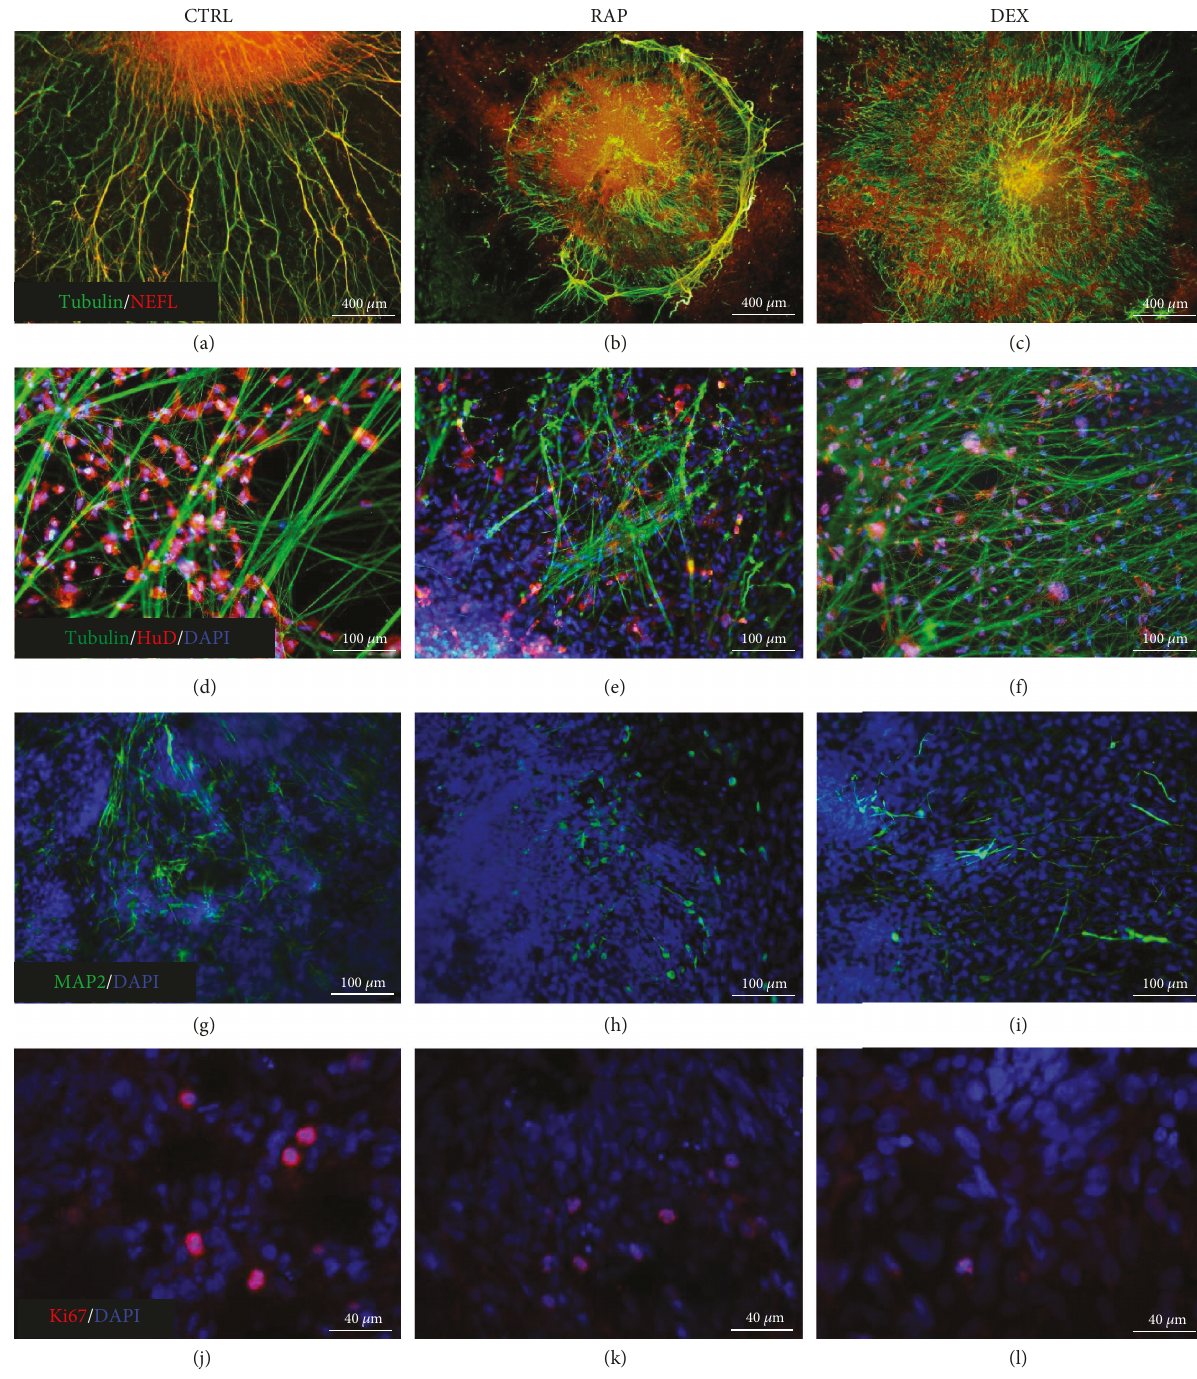
Figure 3: Immuno fl uorescence microscopy to examine the morphologies of cells from retinal organoids after exposure to immunosuppressants (a) Axons in the control group were long and strong and most expressed tubulin and NEFL (detected via immuno fl uorescence staining) indicating that the cells in this group could develop mature axons. (b) In the presence of rapamycin (RAP), the axons surrounding the organoid were observed to be tangled. Thicker axons stained positive for both tubulin and NEFL, whereas thinner axons within the organoid stained positive for only tubulin, suggesting that many axons in this group were still immature. (c) In the presence of dexamethasone (DEX), axons were short and thin and most stained only for tubulin, indicating that most axons in this group were immature. (d) Cells stained positive for HuD in the control group also exhibited long and dense dendrites that (g) stained positive for MAP2. (e, f) RAP-treated and DEX-treated organoids showing cells staining positive for HuD. (h, i) RAP- and DEX-treated organoids showing cells staining positive for MAP2. Proliferative cells in (j) control, (k) RAP, and (l) DEX groups stained positive for Ki67. CTRL: control group; RAP: rapamycin-treatment group; DEX: dexamethasone-treatment